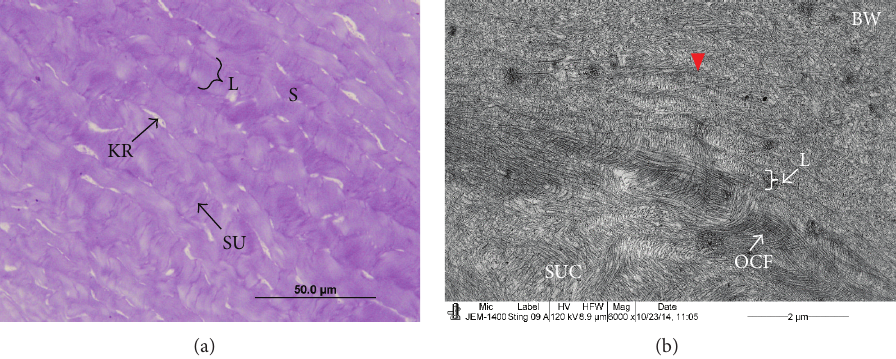
Figure 1: Light and electron micrograph of stingray cornea; (a) middle part of the stroma showing suture running obliquely to the parallel running lamellae; (b) part of the BW and anterior stroma showing BW fibrils blending into the most anterior stromal lamellae, thin lamellae, orthogonal CFs, and orthogonal suture CFs. BW: Bowman’s layer, KR: keratocyte, L: lamellae, S: stroma, SU: suture, OCF: orthogonal running CFs, and SUC: orthogonal suture CFs. Table 1: Mean collagen fibril diameter of anterior, middle, and posterior stroma of stingray and shark cornea. Density/ 𝜇 m Mean interfibrillar spacing ± standard error (nm) Stingray Shark Stingray Shark Stingray Shark Anterior stroma 516 547 Middle stroma 444 516 22.12 ± 0.27 ∗ 37.86 ± 0.24 ∗∗ 595 22.21 ± 0.28 ∗ 24.59 ± 0.12 ∗ 37.83 ± 0.28 ∗∗ 35.17 ± 0.23